Question: What does this figure show? Answer in one sentence.
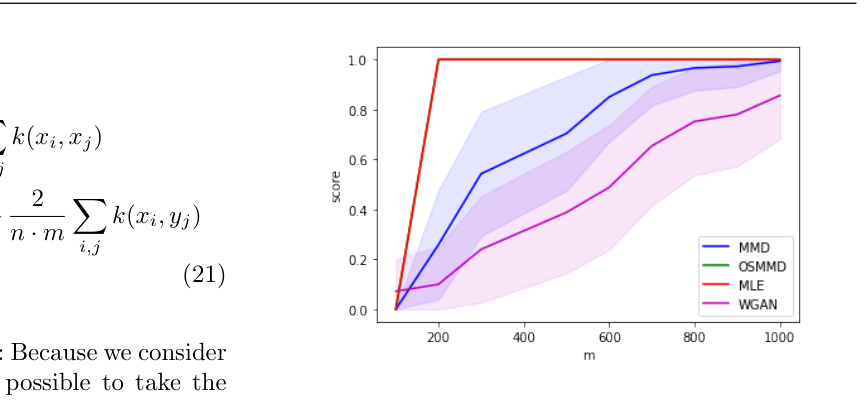
Answer: Success rate in a Gaussian model with un- known mean as a function of m. OSMMD and MLE coincide.